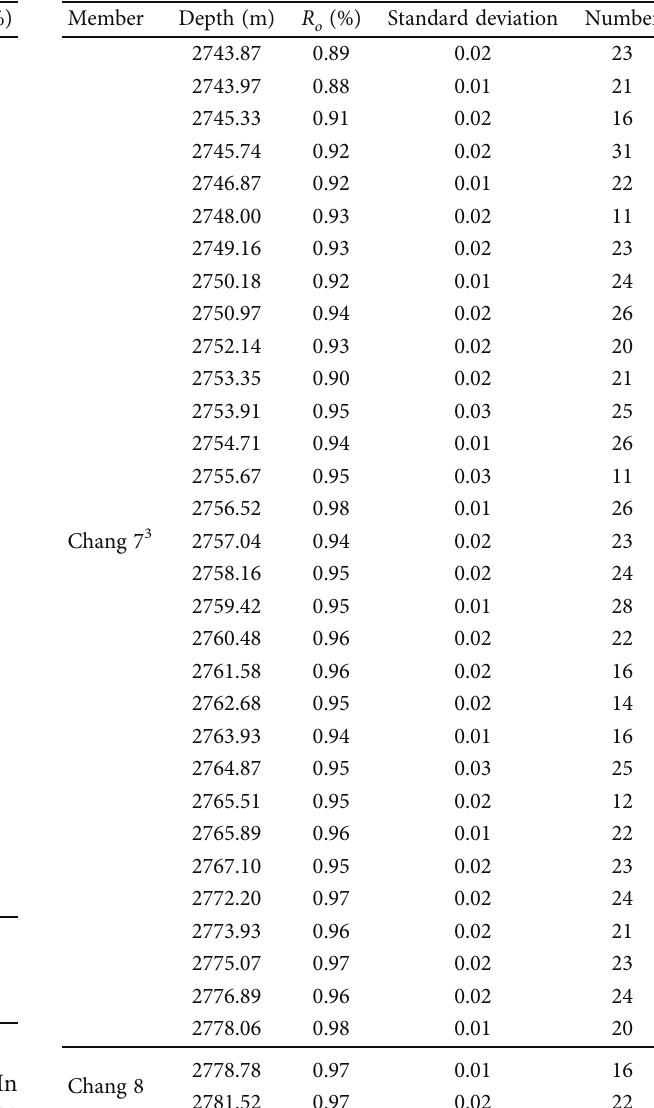
Table 4: Vitrinite re fl ectance ( R ) of Chang 7 3 and Chang 8 o intervals from well DP1 in the western Ordos